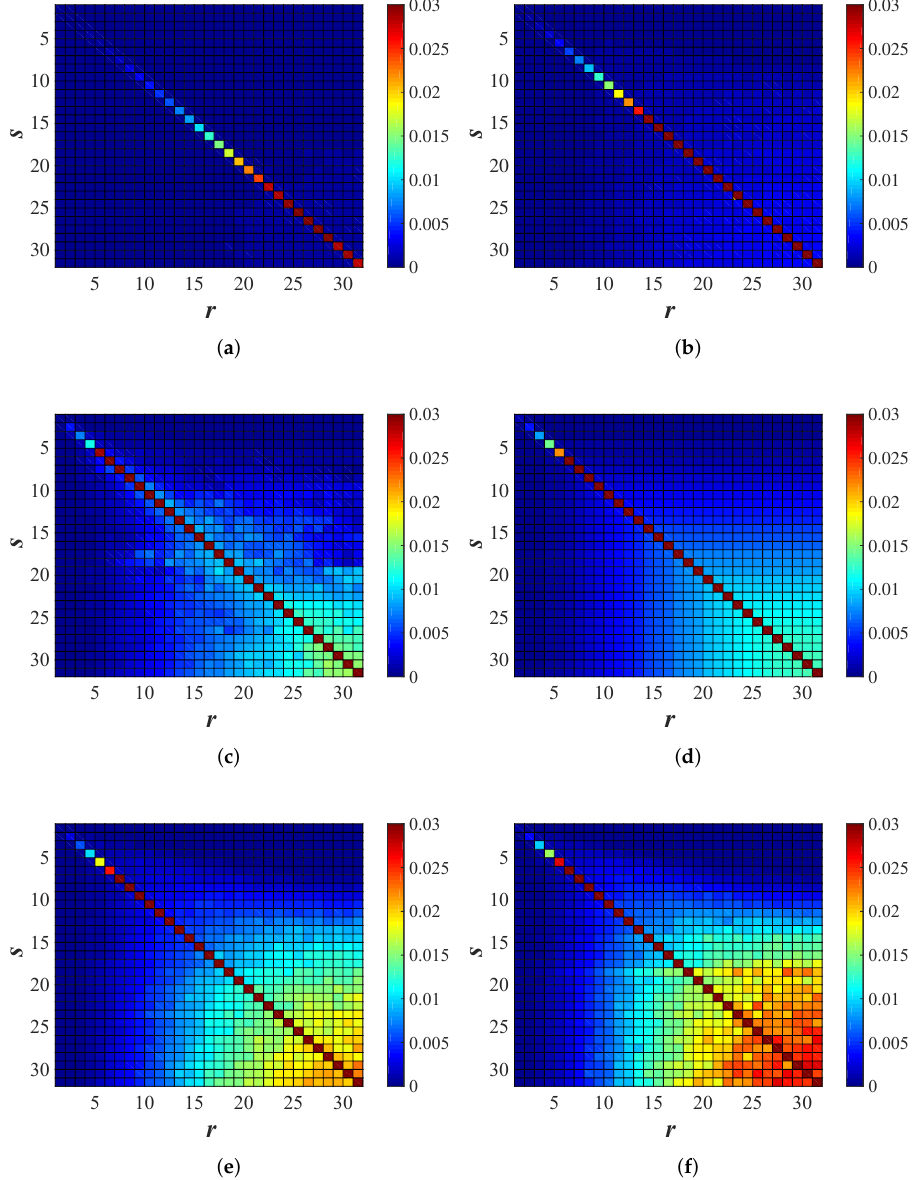
Figure 17. The transfer rate matrix Q sr computed through the linear procedure (Section 3.4) for dif- ferent disorders: ( a ) ξ = 0.1, ( b ) ξ = 0.2, ( c ) ξ = 0.3, and ( d ) the analytical expression (Equation (50)) for ξ = 0.3, ( e ) ξ = 0.4, and ( f ) ξ = 0.5. The first index gave the source s (row) bin and the second the receiver r (column) bin. The non-diagonal elements Q sr were the increase rates of energy in bin r by receiving energy from bin s . The diagonal elements ( Q ss ) were the attenuation coefficients of − the energy in band/bin s (no Einstein summation implied in ss ).